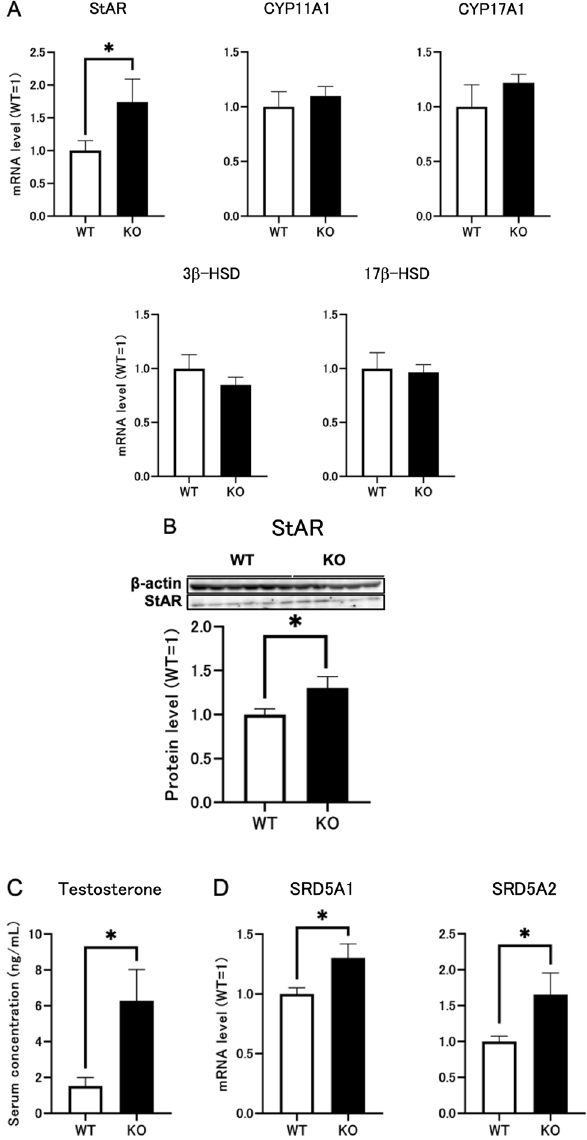
Figure 3. Effects of Dapl1 deletion on sex steroid hormone synthesis in mouse testes at PND49. ( A ) Effect of Dapl1 ablation on the testicular steroidogenesis gene-expression of mRNA coding for StAR, CYP11A1, CYP17A1, 3β-HSD, and 17β-HSD in male mice at PND49. Each bar represents the mean ± S.E.M. of 9–12 mice. ( B ) Effect of Dapl1 ablation on the testicular expression of StAR protein in the mice at PND49. The representative electrophoretic image of each group is shown in the upper panels. The relative level of StAR expression was calculated by normalization to β-actin. Each bar represents the mean ± S.E.M. of 5–6 mice. ( C ) Effect of Dapl1 ablation on circulating levels of testosterone in male mice at PND49. Each bar represents the mean ± S.E.M. of 6–7 mice. ( D ) Effect of Dapl1 ablation on the testicular steroidogenesis gene-expression of mRNA coding for SRD5A1 and SRD5A2 in male mice at PND49. Each bar represents the mean ± S.E.M. of 9–11 mice. Significantly different from the wild-type control: *p < 0.05. DAPL1 death-associated protein-like 1, StAR steroidogenic acute regulatory protein, CYP cytochrome P450, 3β-HSD 3β-hydroxysteroid dehydrogenase, 17β-HSD 17β-hydroxysteroid dehydrogenase, SRD5A1 steroid 5α-reductase 1, SRD5A2 steroid 5α-reductase 2, PND49 postnatal day 49. Full-length blots for ( B ) are presented in Supplementary Figs. S7 and